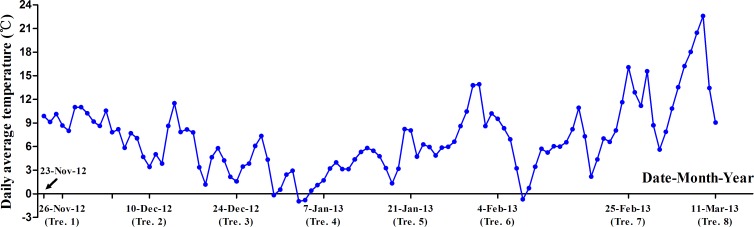
Change in the daily average temperatures (℃) in sampling base from November 23, 2012 to March 11, 2013.